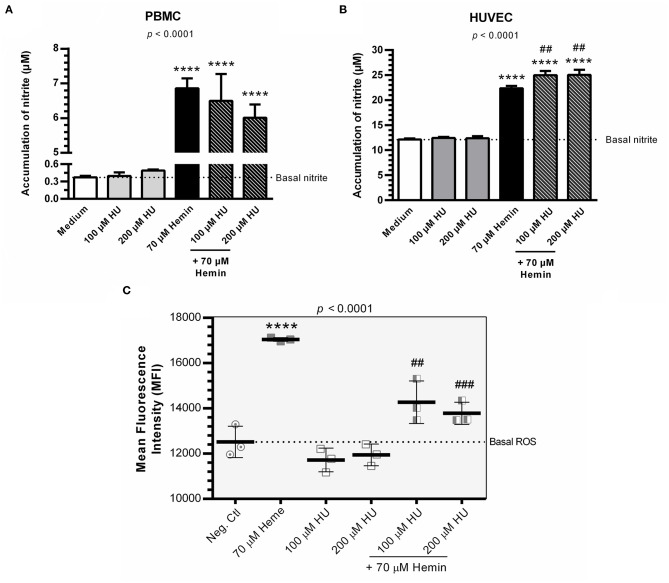
NO production and formation of intracellular ROS in the presence of Hydroxyurea and/or hemin. (A) Production of NO in supernatants of PBMCs in response to various treatment protocols. Results correspond to means ± SD of three independent experiments. Statistical significance determined by one-way ANOVA, p < 0.0004, followed by Tukey's post-hoc test: HU alone or in combination with hemin vs medium, or hemin vs medium, **p < 0.01; HU + hemin vs hemin, ##p < 0.01. (B) Production of NO in supernatants of HUVECs in response to various treatment protocols. Results correspond to the mean ± SD of three independent experiments. Statistical significance determined by one-way ANOVA, p < 0.0001, followed Tukey's post-hoc test: HU alone or HU + hemin vs. medium, or hemin vs. medium, ****p < 0.0001; HU + hemin vs. hemin, ##p < 0.01. (C) Decreased ROS formation in HUVECs using the oxidant-sensing fluorescent probe 10 μM 2', 7'-dichlorodihydrofluorescein diacetate (DCFH-DA). Statistical significance determined by mean fluorescence intensity (MFI) values representative of the mean ± SD of three experimental replicates. One-way ANOVA, p < 0.0001, followed by Tukey's post-hoc test: HU alone or associated with hemin vs. medium, or hemin vs. medium, ****p < 0.0001; HU + hemin vs. hemin, ##p < 0.01; ###p < 0.001.